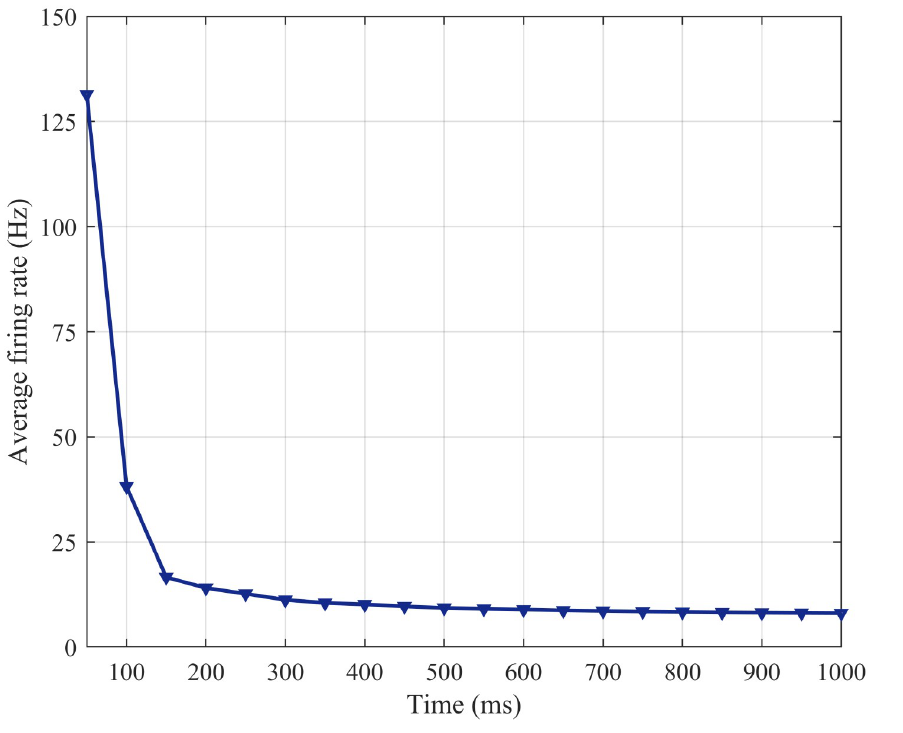
Fig 14. The change in the average FR with time.